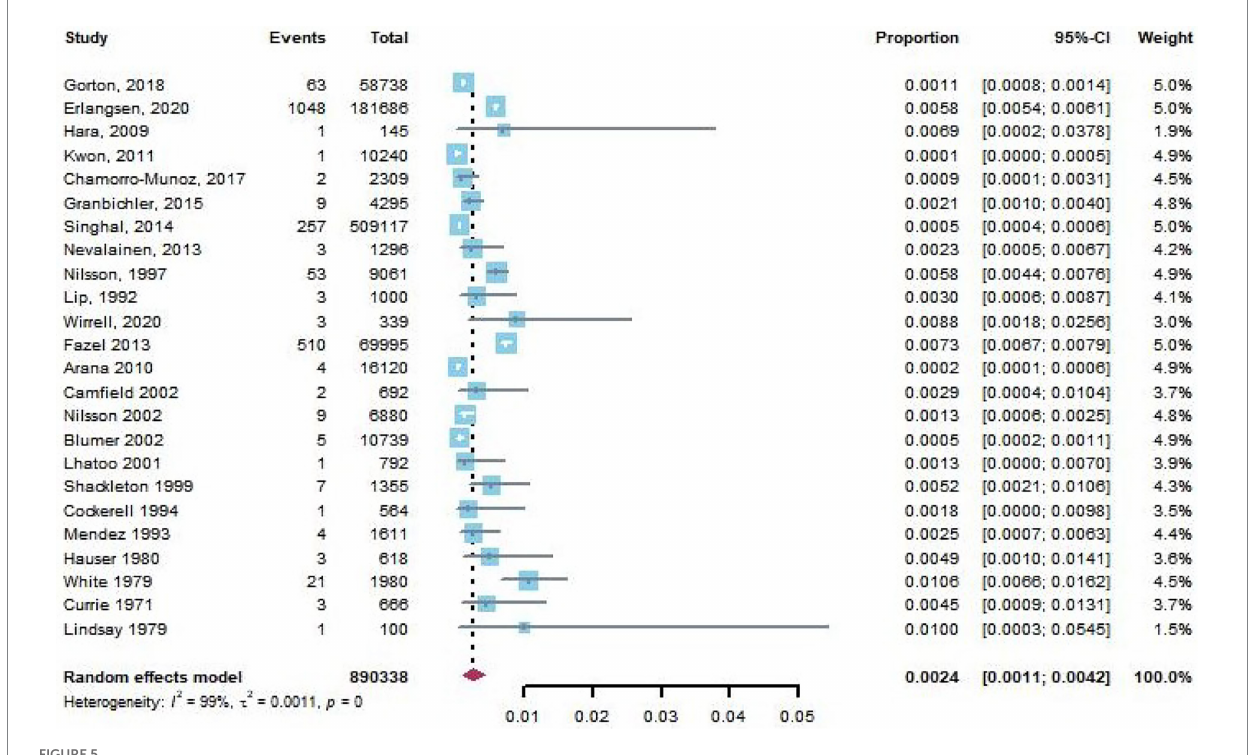
FIGURE 5 The crude rate of completed suicide in patients with